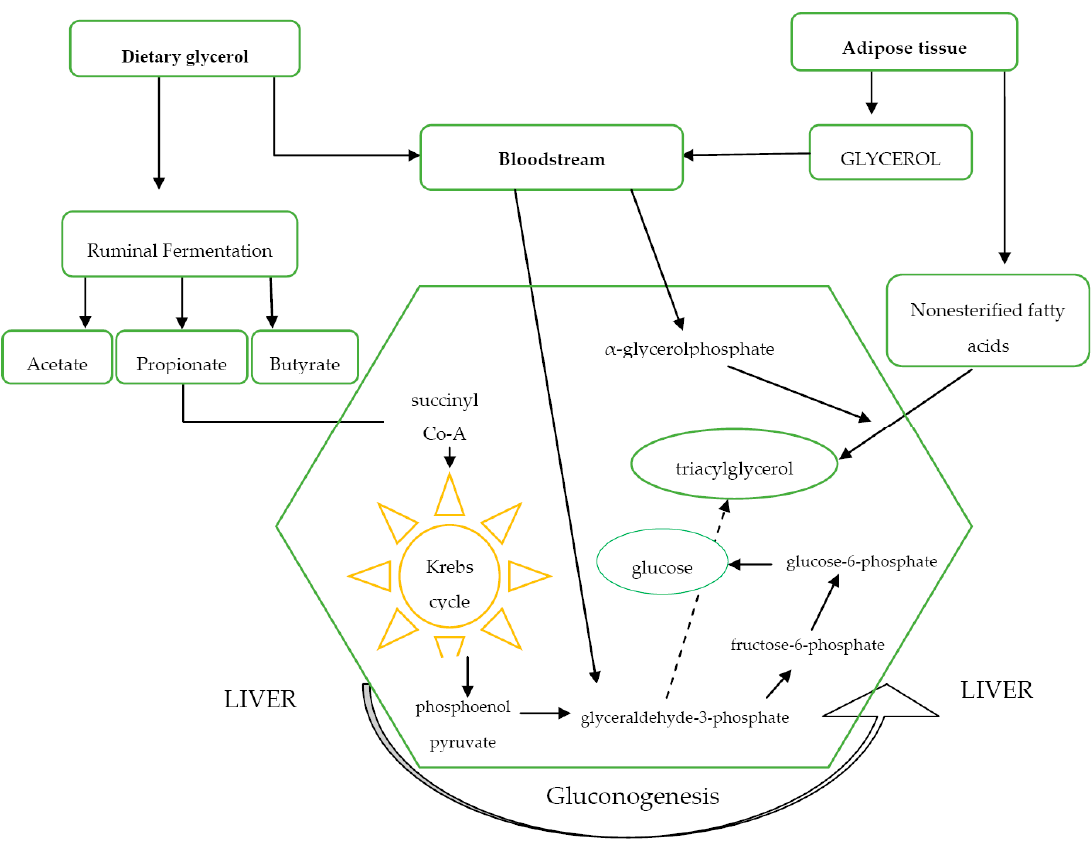
Figure 1. Pathways of glycerol transfer / metabolism and liver gluconeogenesis in dairy cows, modified from Osman et al. [ 12 ] .